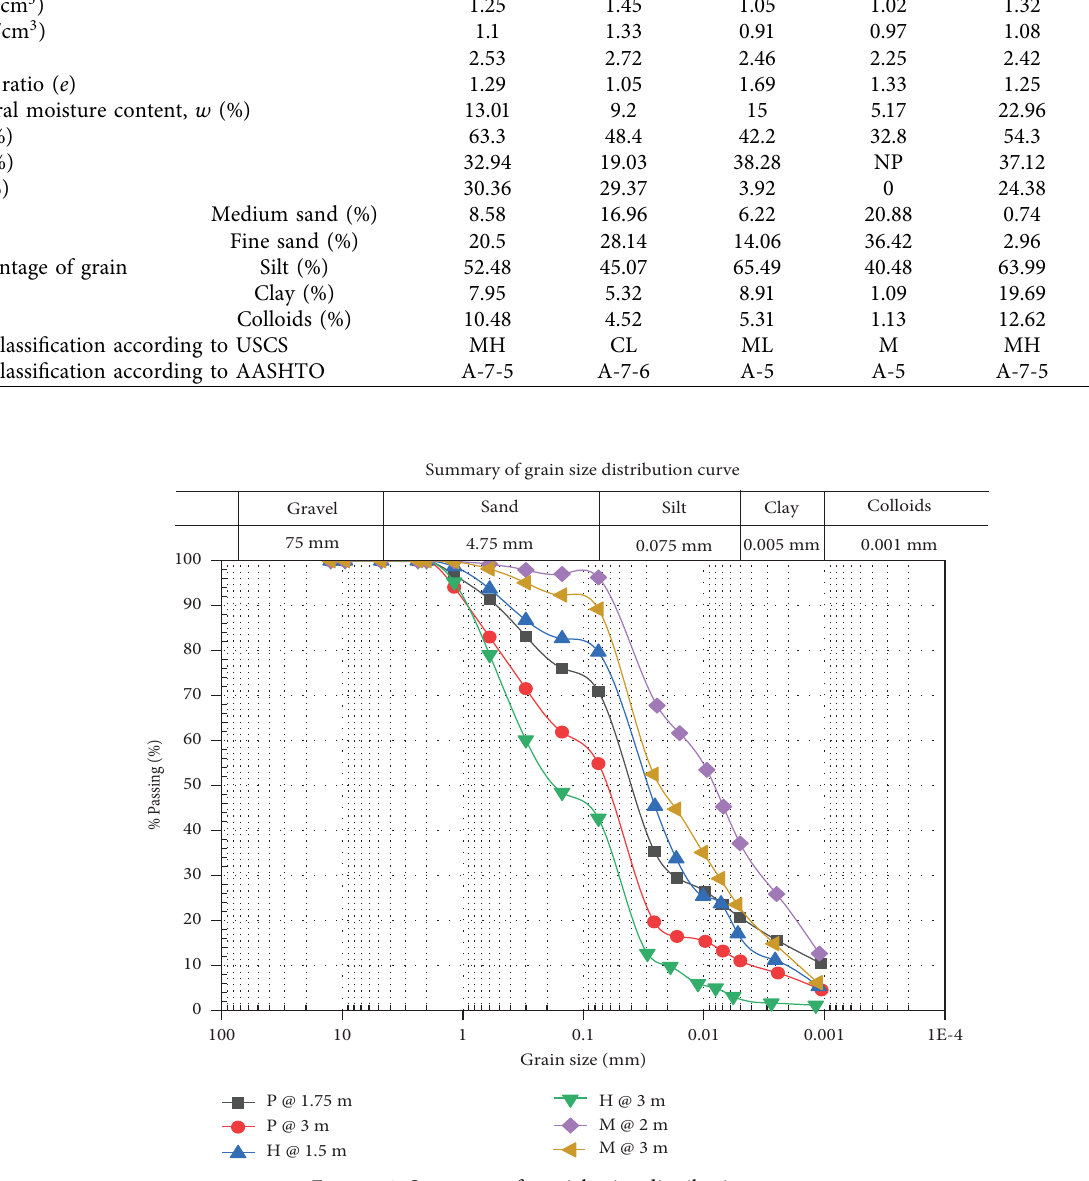
Figure 4: Summary of particle size distribution